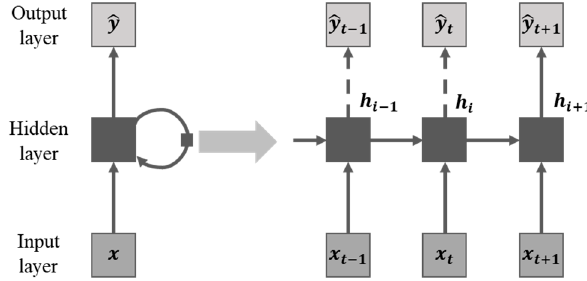
Figure 1. Structure of recurrent neural network [26].